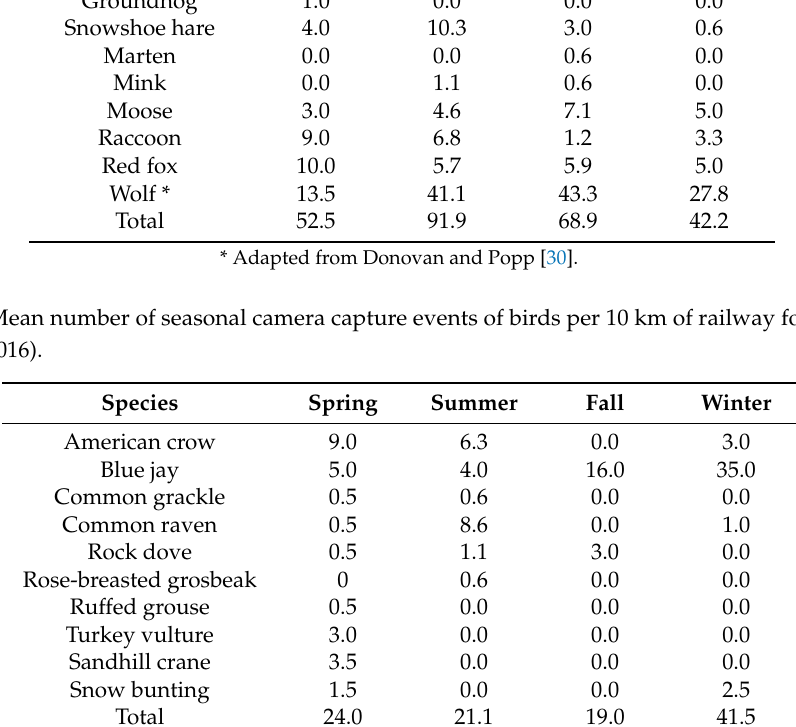
Rose-breasted grosbeak